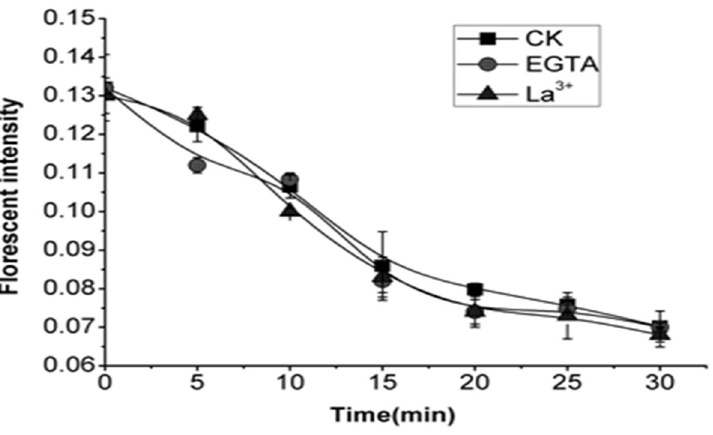
Figure 6. Effects of EGTA and La 3+ on 1 mM OA-treated cell pH cyt .